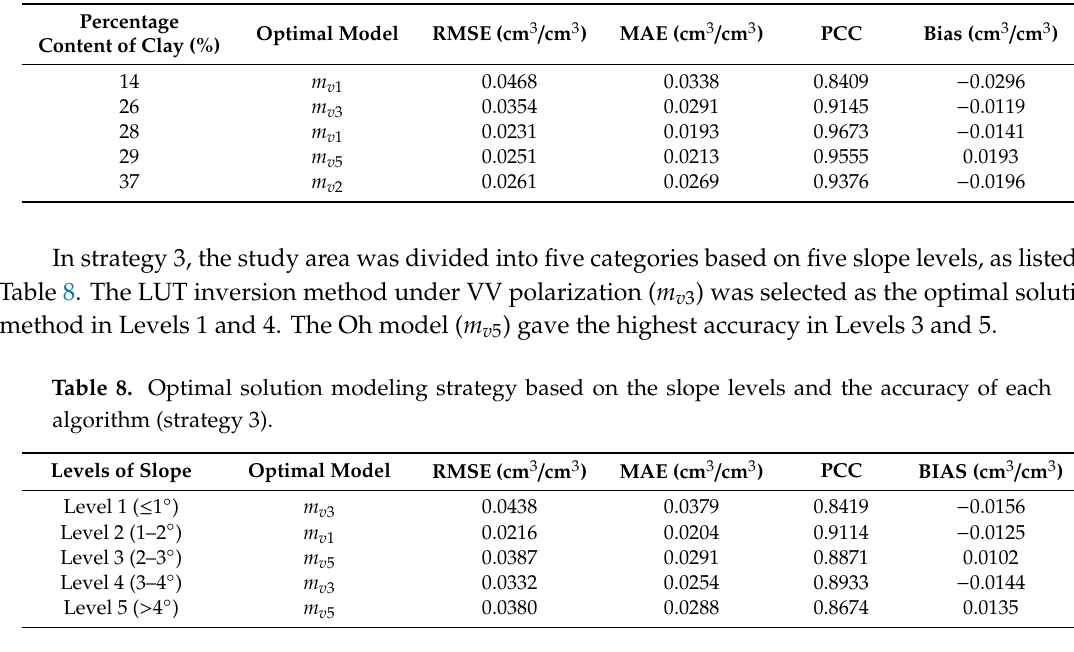
Table 7. Optimal solution method strategy based on the percentage content of clay and the accuracy of each algorithm (strategy 2).